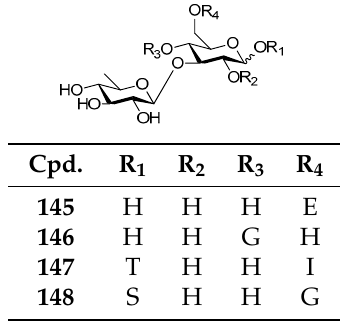
Figure 12. Structures of compounds 145 – 147 .